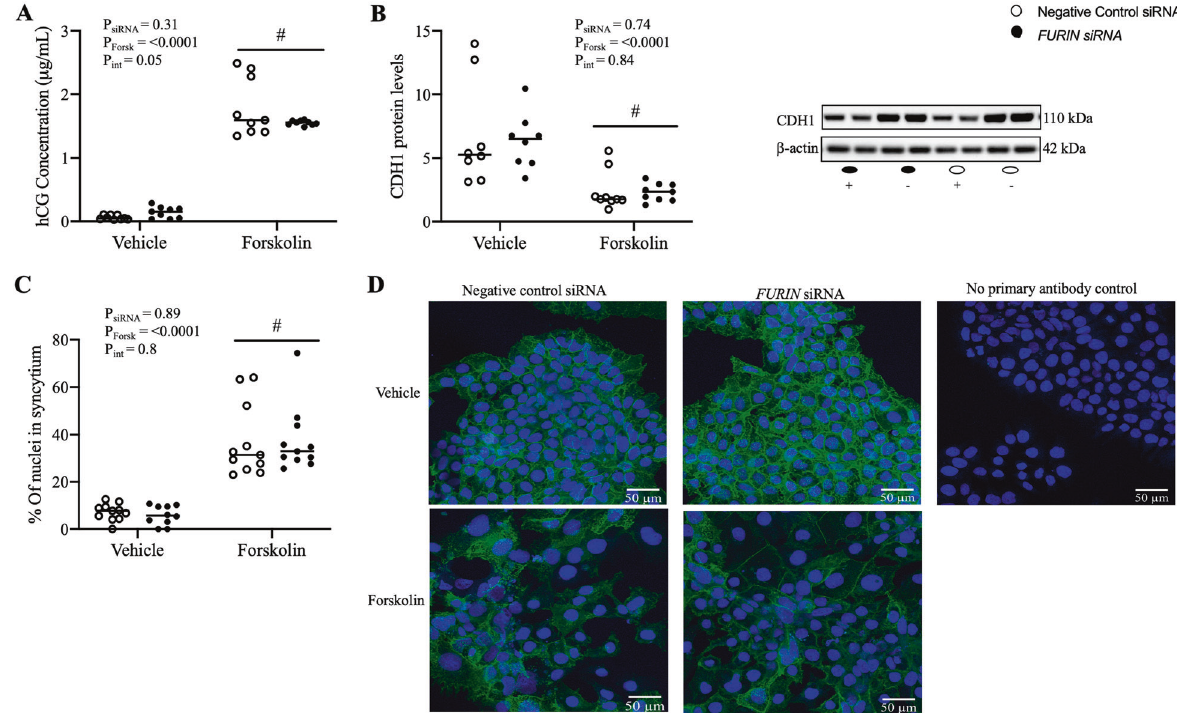
Fig. 3 FURIN knockdown had no effect on forskolin-induced syncytialisation of BeWo choriocarcinoma cells. BeWo cells were treated with FURIN siRNA prior to being induced to syncytialise with forskolin. Forskolin treatment successfully ( A ) increased hCG secretion, ( B ) decreased E-cadherin (CDH1) protein levels and ( C ) increased the percent of nuclei in syncytia (as determined by CDH1 immunostaining). FURIN siRNA knockdown had no effect on ( A ) hCG secretion, ( B ) E-cadherin (CDH1) protein levels or ( C ) the percent of nuclei in syncytia, respectively. Representative images in ( D ) depict cells stained for CDH1 (green) and counterstained with DAPI (blue). No primary antibody control images omitting the primary antibody are included, controlling for non-speci fi c secondary antibody binding. Representative blots are shown where β -actin was used as a loading control. # Denotes signi fi cant difference to the vehicle control. Data are presented as the median with effects of Forskolin (P Forsk ), FURIN siRNA (P siRNA ), or the interaction between these parameters (P Int ) noted. N = 3 experiments in triplicate. For immunocytochemistry only: N = 3 in singlicate (three